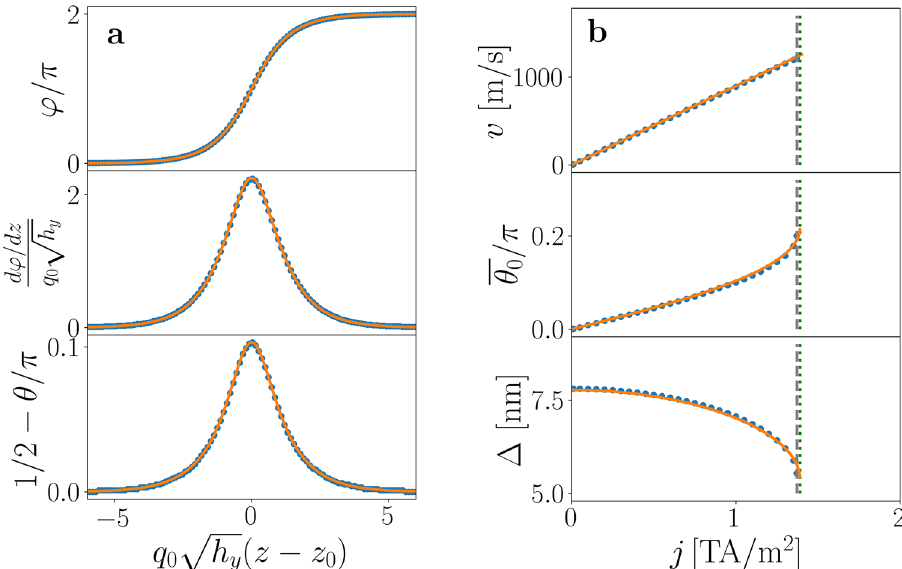
Figure 3. Steady motion of the chiral soliton. ( a ) Steady profiles for κ = − 5.17 , h y = 0.807 , and Ŵ = 0.89 2 ( j = 1TA/m ). Circles correspond to numerical simulations and lines to the BVP. ( b ) Velocity and soliton parameters as a function of the applied current density j . The steady velocity increases linearly with the current, with mobility m = (β/α) b j , as indicated by the continuous line (top panel). Middle and bottom panels: ¯ θ 0 , (tilt of the magnetization in the z direction) increases with j , whilst the soliton width (cid:31) decreases. Both quantities 2 show a considerable change when the critical current j c = 1.372 TA/m , indicated by the vertical dashed line, is approached. Continuous lines correspond to the solution of the corresponding BVP. Vertical dashed and dotted lines correspond to the critical values j c obtained with numerical simulations and with the BVP, respectively.